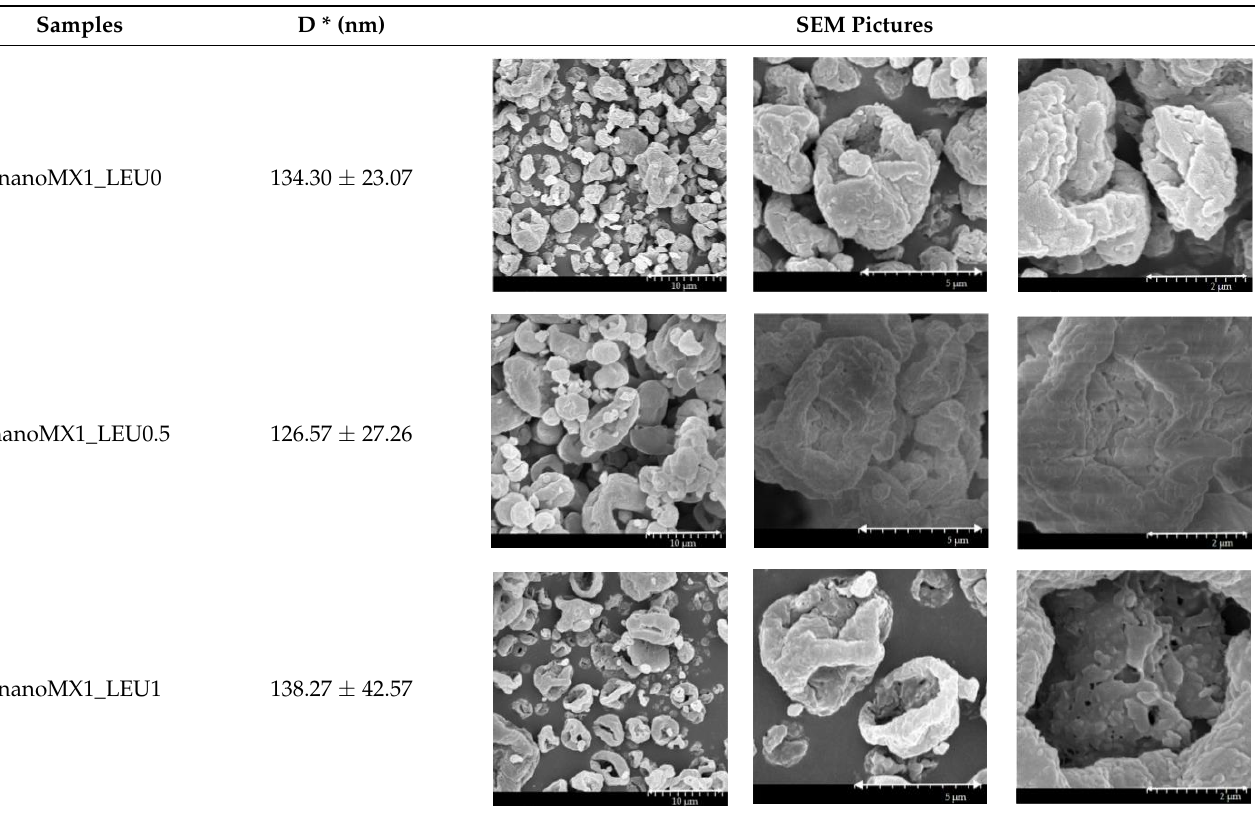
Table 6. Rheology properties of the samples.